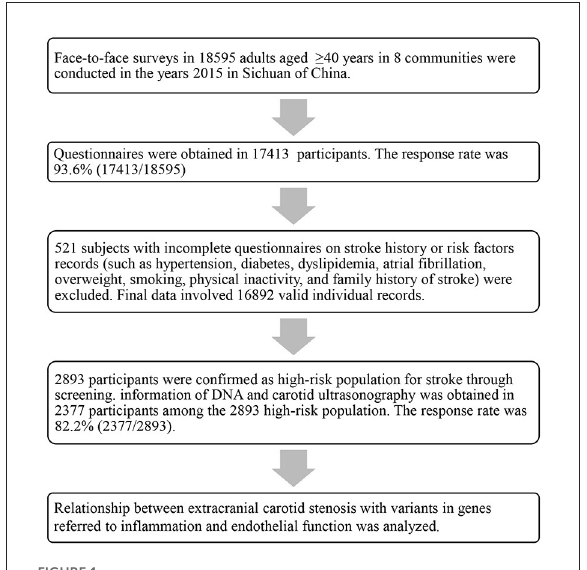
FIGURE1 Research method and data cleaning flow chart in this study.